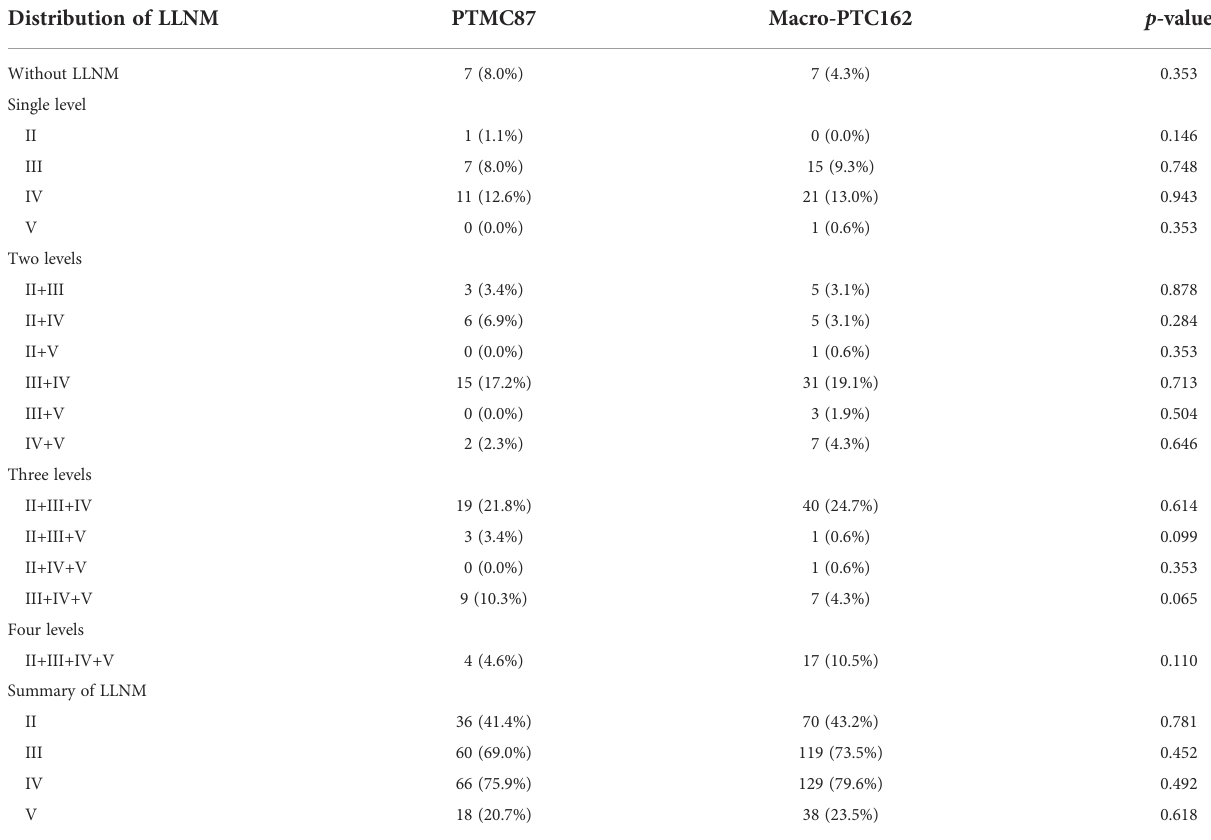
TABLE 2 Distribution of metastatic LNs in the LC of 249 PTC patients who underwent LND. Distribution of